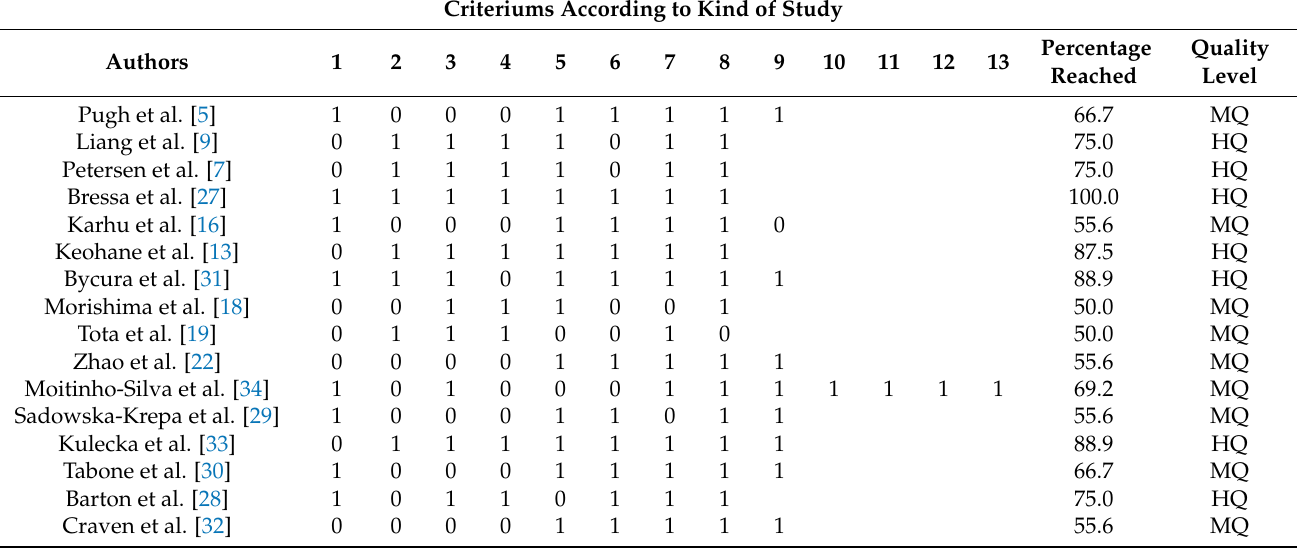
Table 3. Checklist from Joanna Briggs Institute’s criterium according to kind of study, percentage of criterium reached, and quality level of